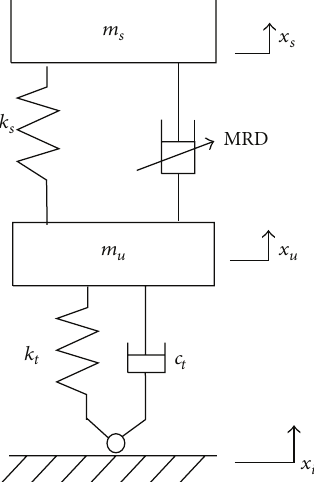
Figure 1: Schematic diagram of 2-DoF MR suspension system.